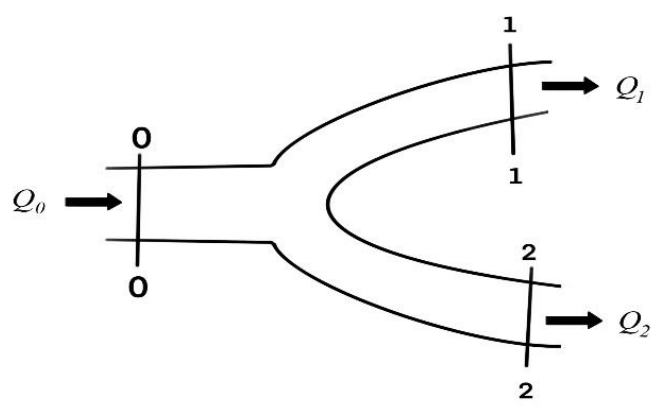
Figure 1. Sketch of branching channel.